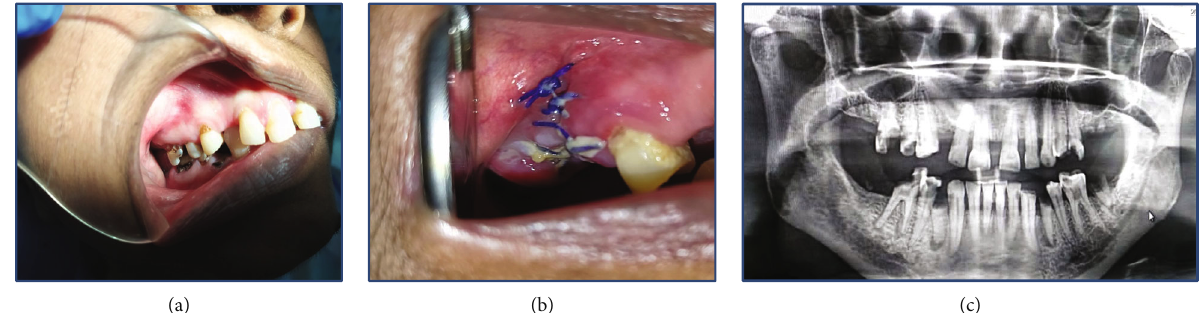
Figure 1: (a) Clinical presentation of the case, di ff use swelling adjacent to the grossly carious teeth on the vestibule, (b) postsurgical healing after 8 days, and (c) the orthopantomography of the patient showing minimal radiolucency on the root apices masked by the maxillary sinus.